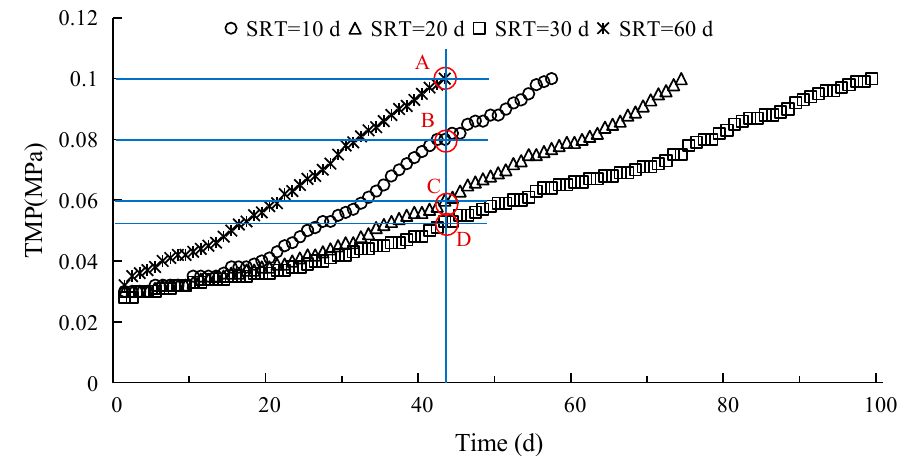
Figure 3. TMP variations under the four different SRT conditions. Variations in SRT can change the sludge load, which has an important influence on the growth and reproduction of microorganisms and their composition. The microbial community structure at class level in activated sludge under different SRT conditions is illustrated in Figure 4. Analysis revealed that Sphingobacteriia were the most abundant microorganisms at an SRT of 10 d, with a relative abundance of 39.0%. The most abundant microorganisms observed at SRTs of 20 d, 30 d, and 60 d were all Betaproteobacteria with relative abundances of 12.1%, 24.3%, and 20.9%, respectively.